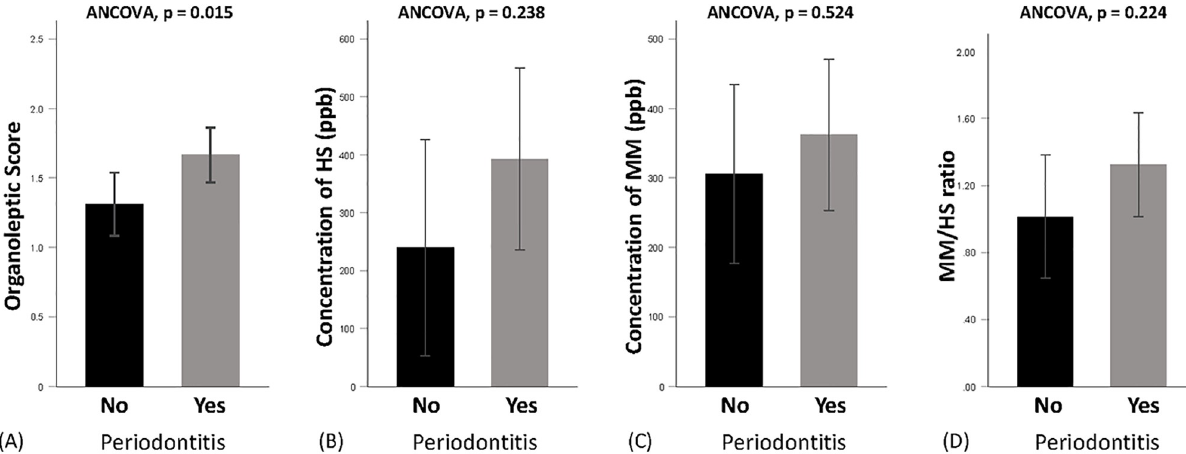
Fig 3. Adjusted relationship between periodontitis and oral malodor parameters. (A) organoleptic score ( n = 302); (B) hydrogen sulfide (HS) level ( n = 111); (C) methyl mercaptan (MM) level ( n = 111); (D) MM/HS ratio ( n = 111). Each bar and error lines represent the mean ± standard error for periodontitis no and yes groups. P values are obtained from ANCOVA adjusted for age, sex, education level, tooth-brushing frequency, denture- wearing, hyposalivation, tongue coating, preference for onion, drinking, smoking, obesity, diabetes, hypertension, ear-nose-throat diseases and gastrointestinal